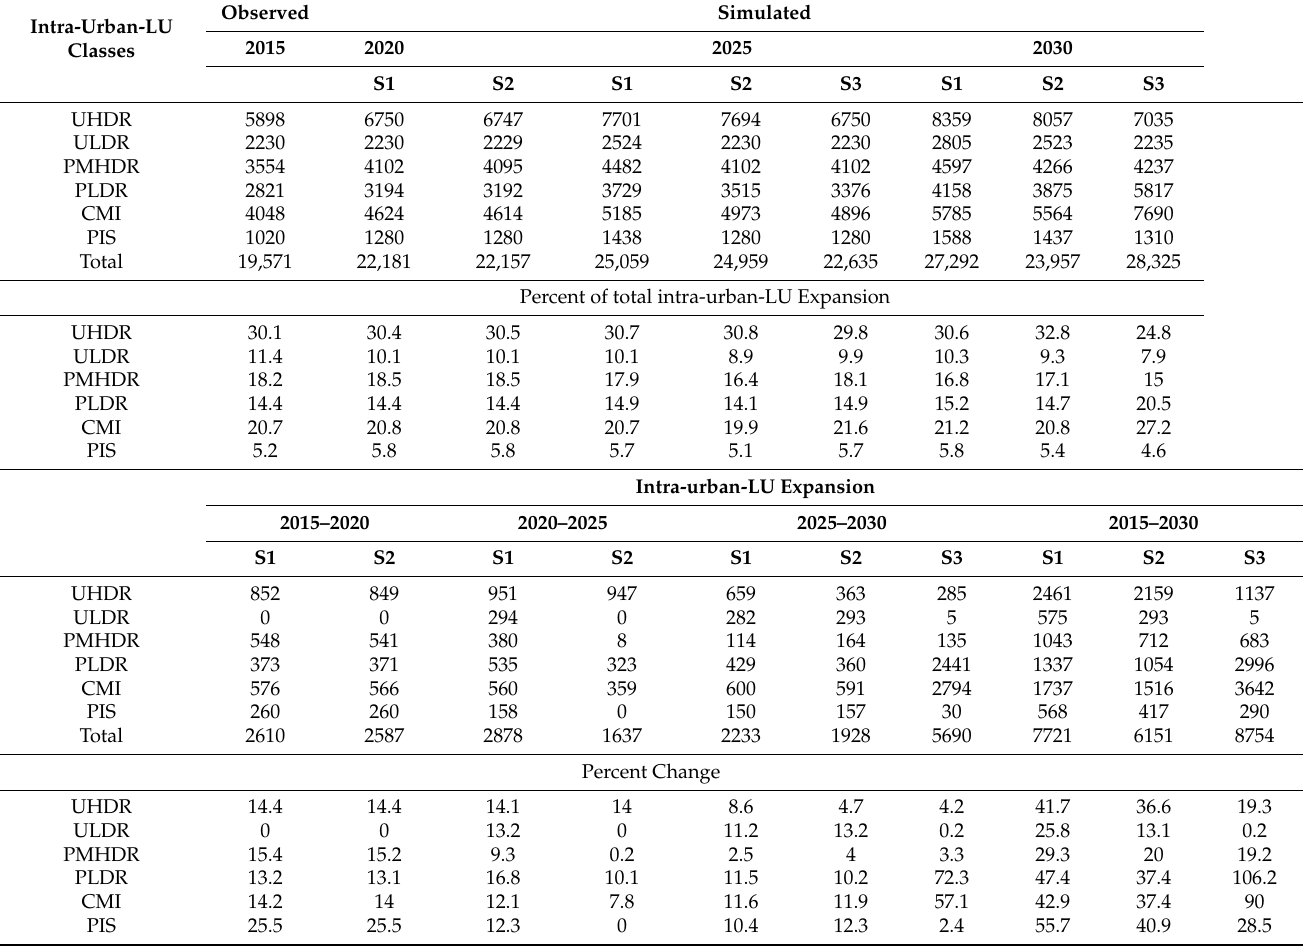
Table 5. Intra-urban-LU (ha) scenario (S) simulation results for Lusaka city, Zambia, with projected results for 2025 and 2030. Refer to Figure 6 for